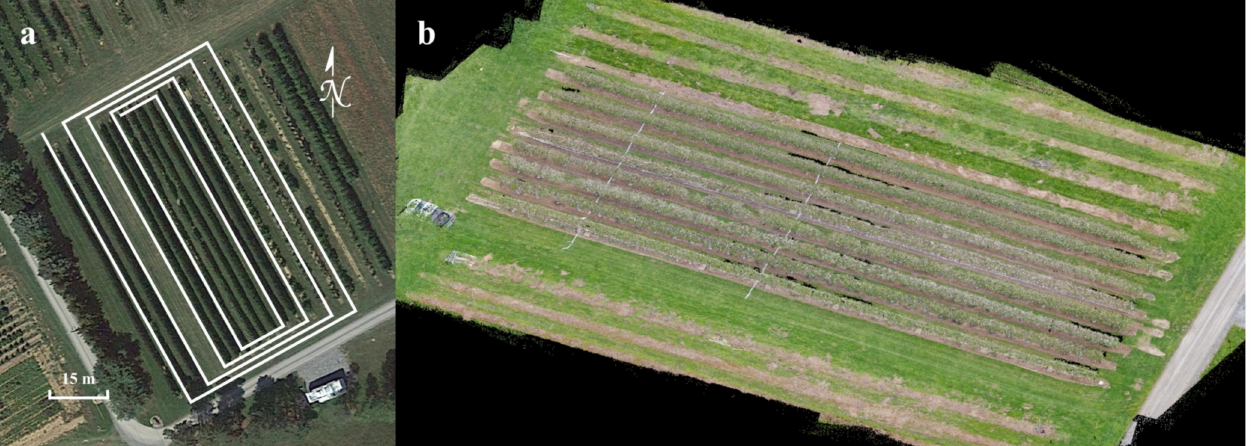
Figure 4. The apple orchard where the field experiment data collection was conducted: ( a ) the flight path of the UAV flight missions; ( b ) a reconstructed apple orchard point cloud using the set of RGB images collected on 3 May 2022 that shows the tarp